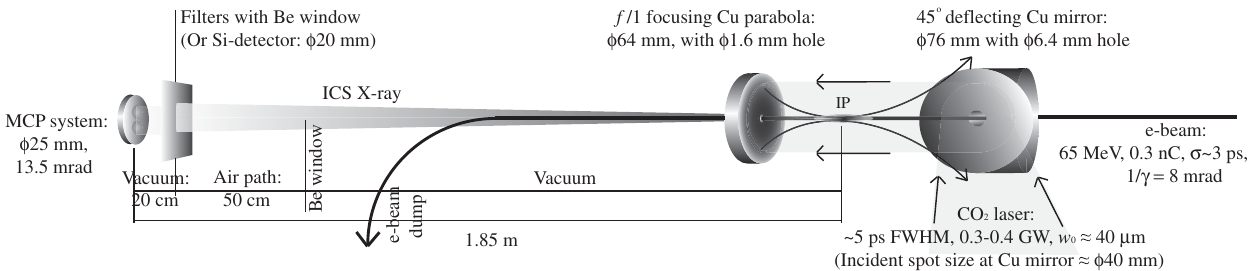
FIG. 3. Schematic layout of nonlinear ICS experiment at the BNL ATF.